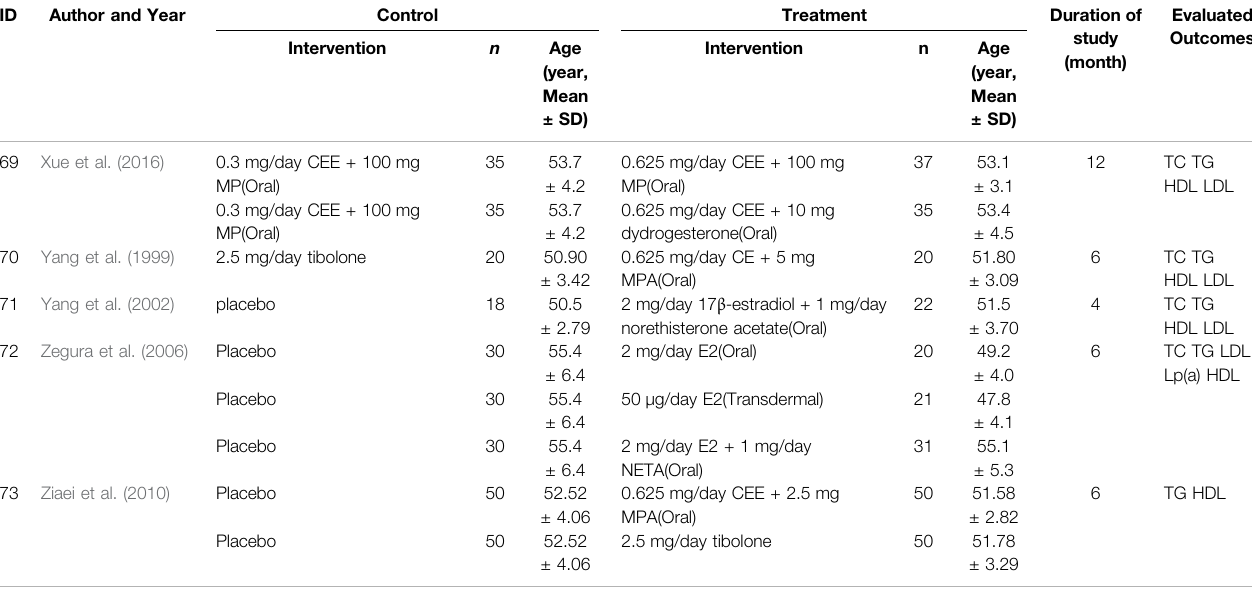
Table 1 . The details for risk of bias are available in Figure 2 and Figure 3